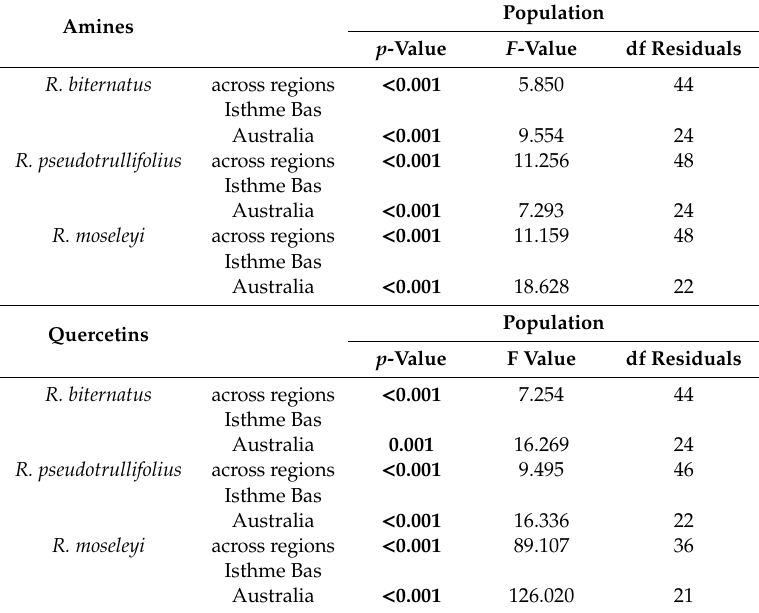
Table 2. Di ff erences among populations in the composition of amines or quercetins *. Amines